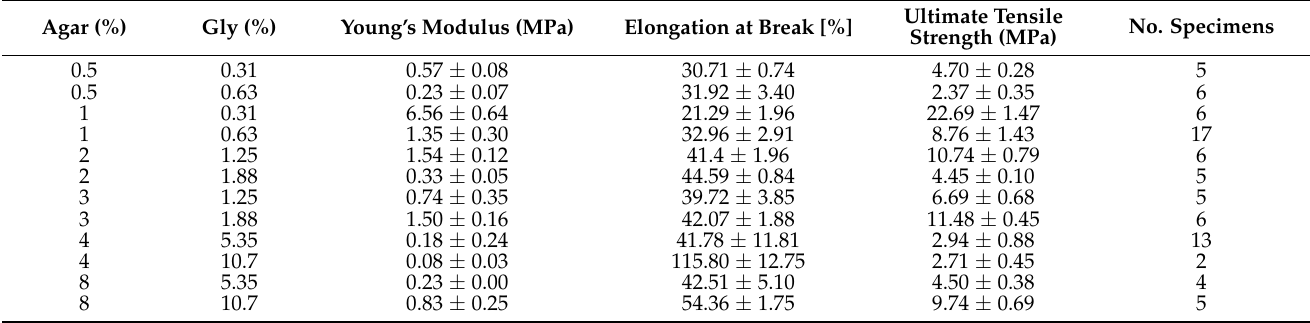
Table 2. Formulations and properties of agar biopolymer films ( ± standard